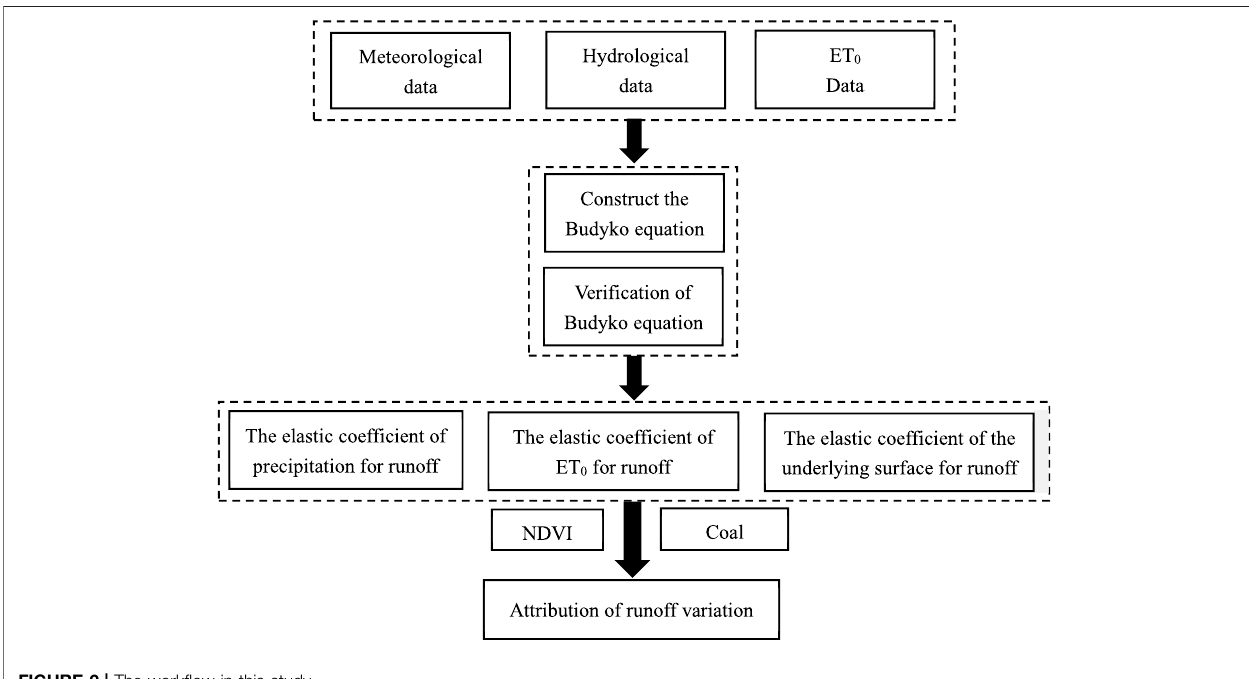
FIGURE 2 | The work fl ow in this